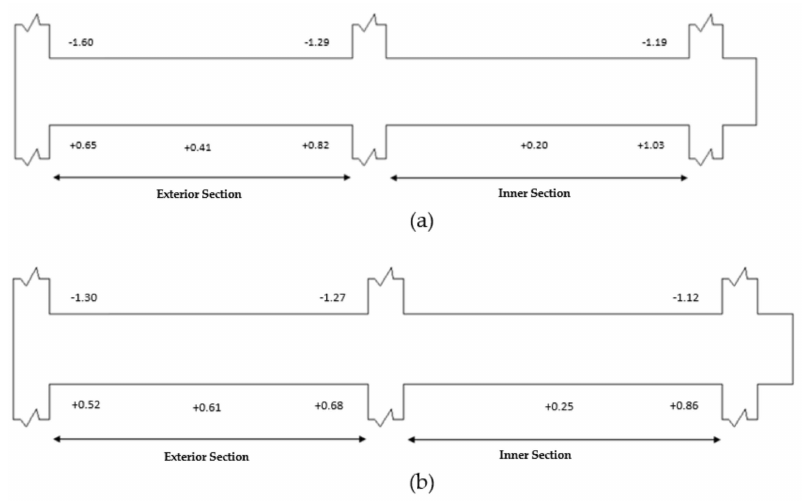
Figure 3. Maximum moments in beams: ( a ) option 1, ( b ) option 2.